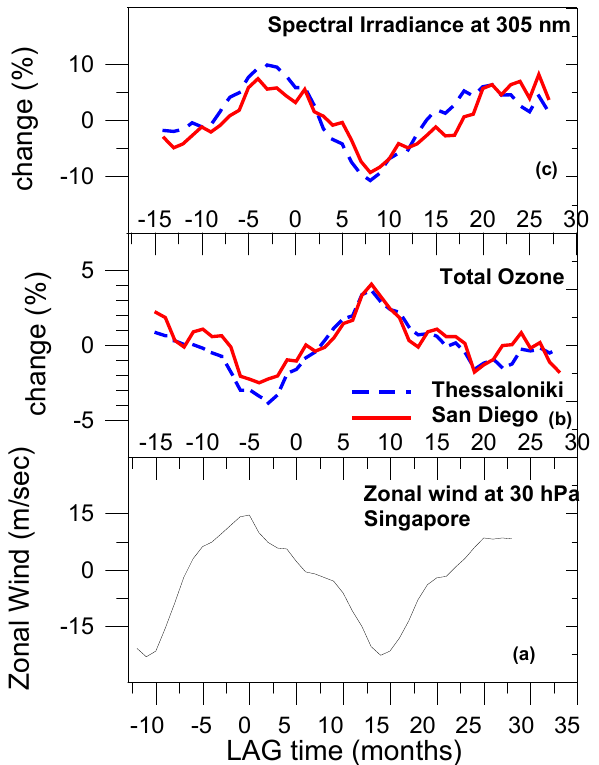
Fig. 3. Composites of (a) 30 hPa zonal wind at Singapore, (b) total ozone at Thessaloniki (dotted line) and San Diego (solid line), and (c) solar irradiance at 305 nm. The composites have been calculated for the last four QBO cycles (1990–1997). Total ozone and irradi- ance measurements correspond to sky conditions with cloud cover < 4/8 and a solar zenith angle of 63 ◦ .